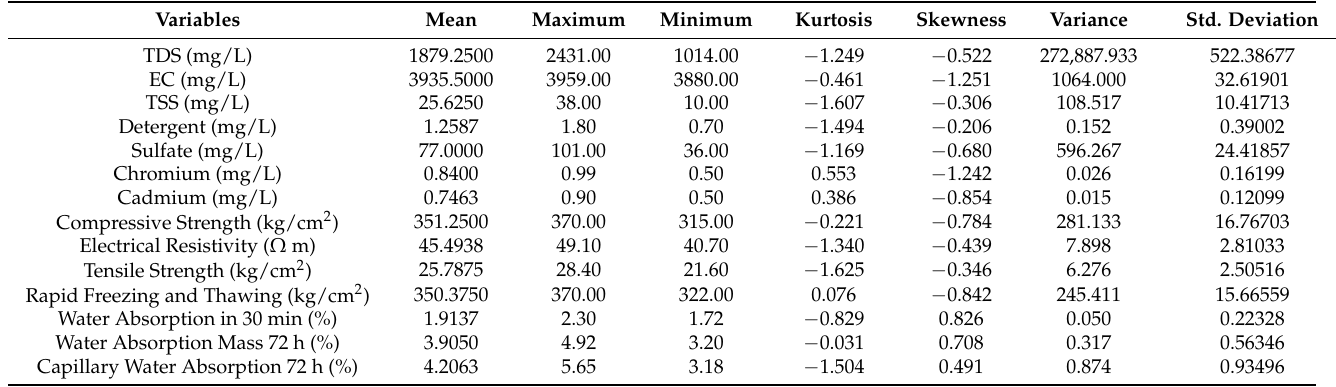
Table 10. Statistical characteristics of